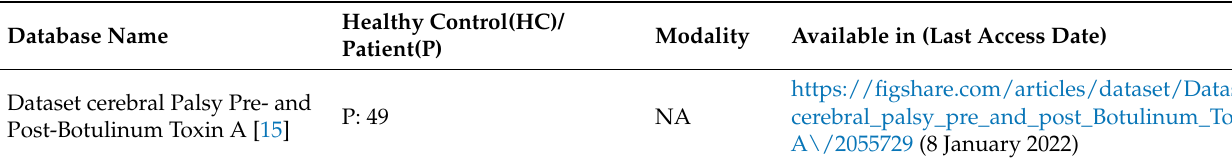
Table 4. A tabulation of popular datasets of Cerebral palsy.